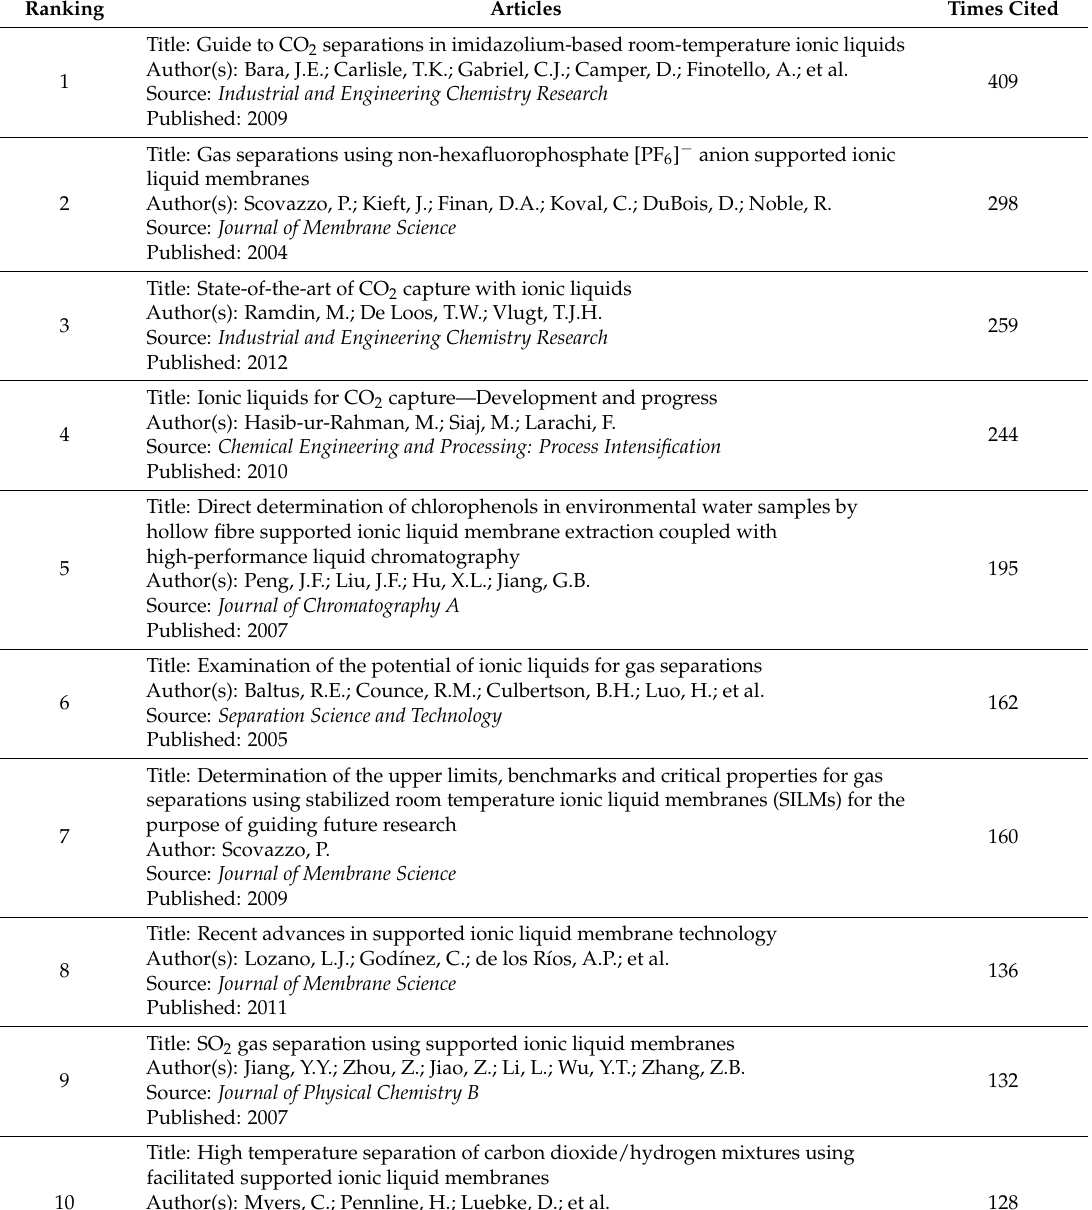
Table 5. The top 10 most cited